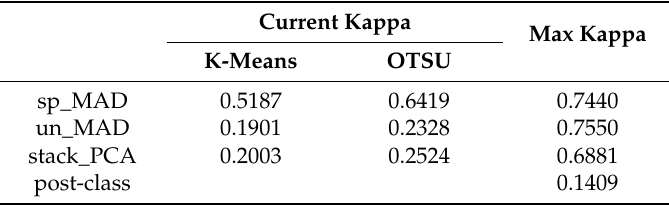
Table 1. Max Kappa and current Kappa for supervised MAD and comparative